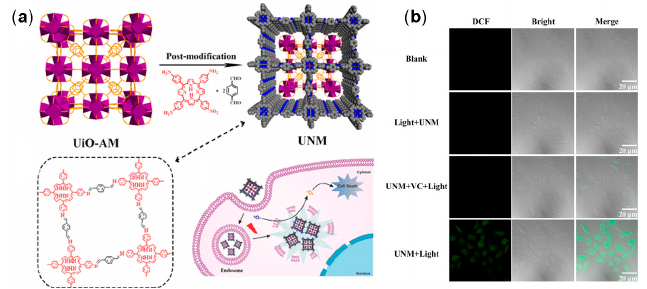
Figure 14. Schematic representations of preparation ( a ) and photodynamic effect ( b ) of MOF@COF. Reproduced with permission from [195]. Copyright American Chemical Society, 2017.